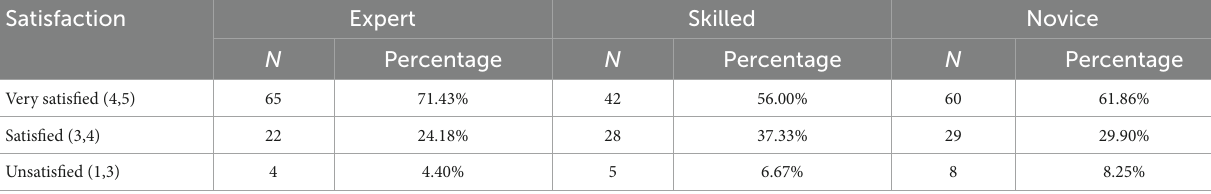
TABLE 8 Satisfaction with expert, skilled, and novice teachers in terms of Sound ( N = 263). Satisfaction